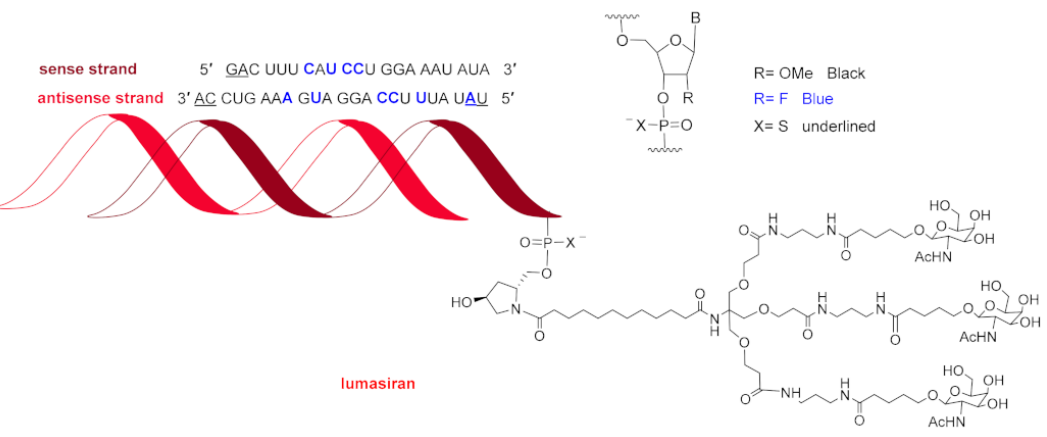
Figure 8. Structure of lumasiran.